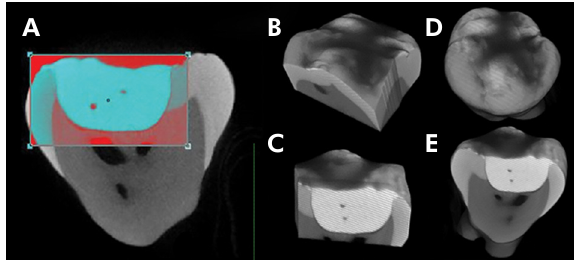
Figure 1. 3D reconstruction of cavity filled with resin composites. Illustrative 2D slice showing the region of interest - ROI (Figure A - red square). Restoration at different angles (B, C, D, and